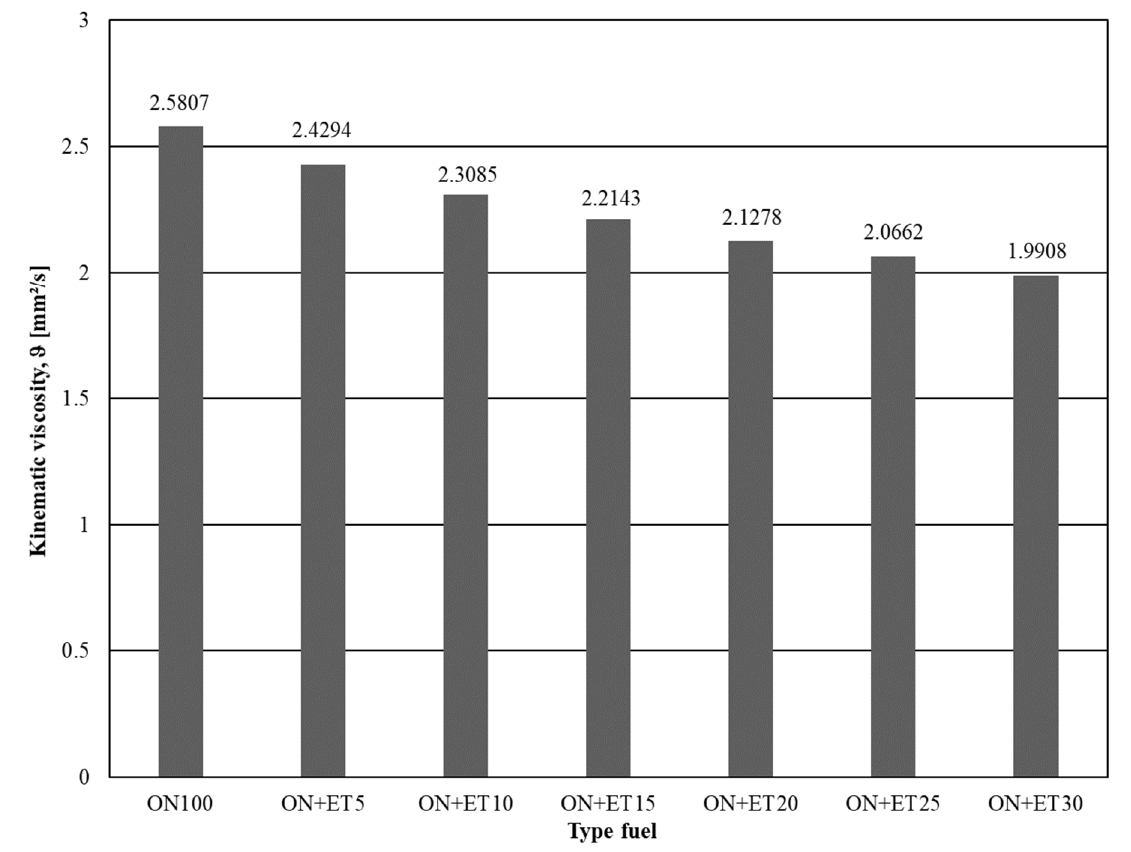
Figure 7. The compared kinematic viscosity values in the fuels investigated. The addition of ethanol to diesel oil led to a change in the range of the spray